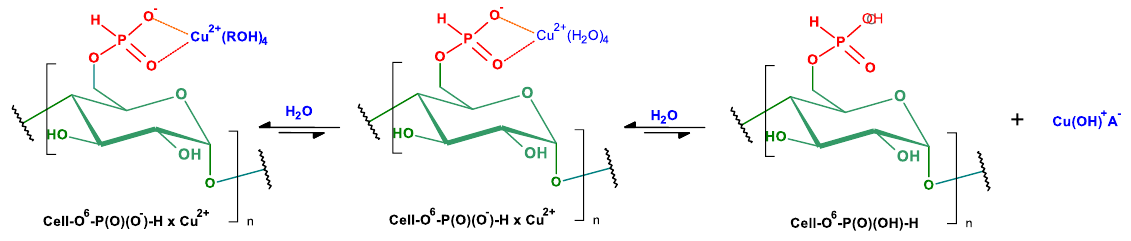
Figure 19. Release of copper ions from composite Cell- O 6 -P(O)(O - )-H × Cu 2+ (A — anion derived from agar gel buffer).